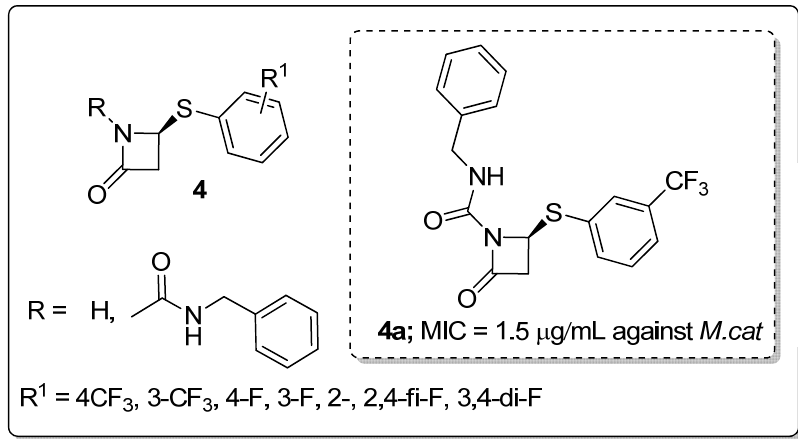
Figure 6. The antimicrobial activity of the most potent β -lactam analog 4a .